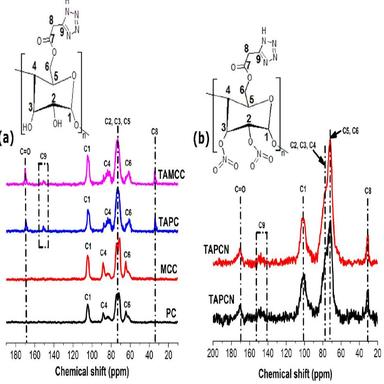
13C solid-state NMR spectra of (a) unmodified precursors and their functionalized derivatives; (b) tetrazole-acetate functionalized nitrated polymers.